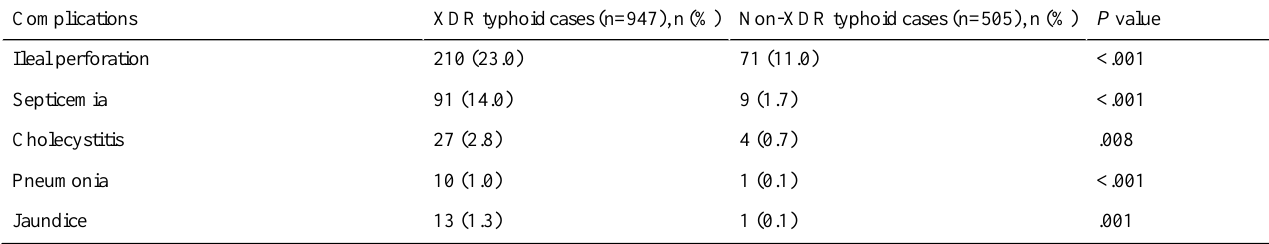
Table 3. Frequency of complications among hospitalized patients with XDR a typhoid and those with non-XDR typhoid in Hyderabad, Pakistan, from October 1, 2016, to September 30, 2018